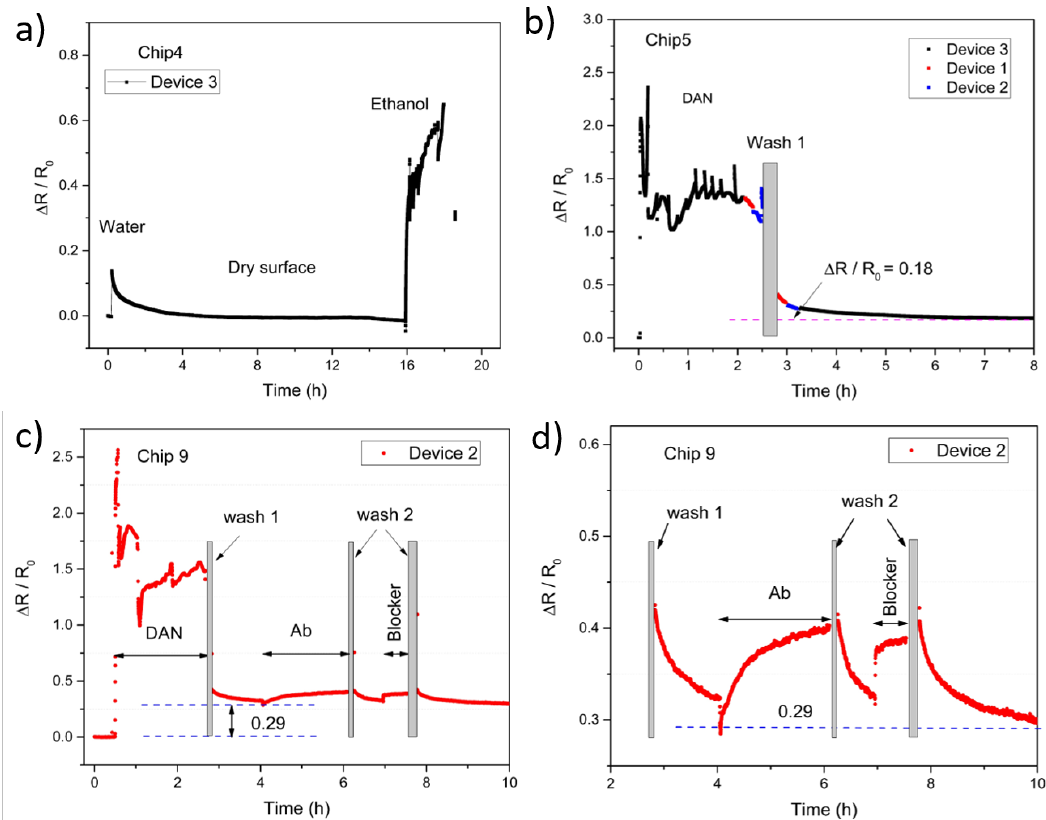
Figure 4. Real-time resistance measurements of the graphene functionalization process. Where ∆ R = R Device − R 0 , and R 0 is the intrinsic device resistance. ( a ) Control experiment: Washed with DI water, left over-night, followed by the addition of 20 µ L of 70% ethanol. ( b ) 2 h DAN incubation at RT, signal spikes due to topping up of the droplet to avoid evaporation of the DAN during incubation, followed by wash 1 (wash 1 = wash with ethanol, followed by DI water and gently dried with N 2 ). ( c ) and ( d ) DAN incubation followed by wash 1, subsequent bio-functionalization stages (antibody and blocker incubations), followed by wash 2 (wash 2 = wash with 1 × PBS (pH 7.4), followed by DI water and gently dried with N 2 ).